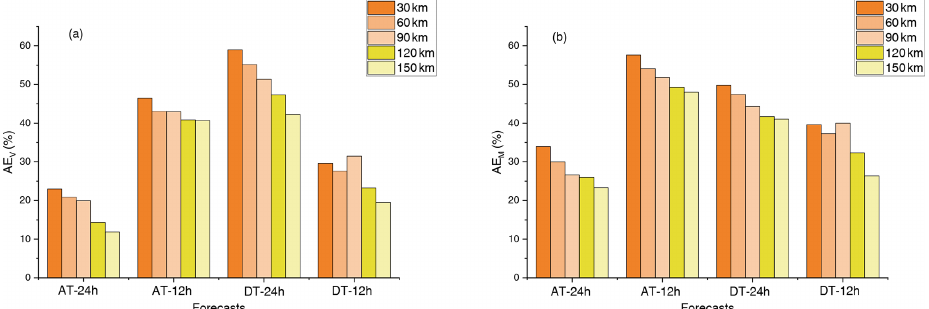
Figure 10. The bar plots of (a) AE V and (b) AE M values of the four forecasts, when the additional observations are deployed within a limited size of area with different observing